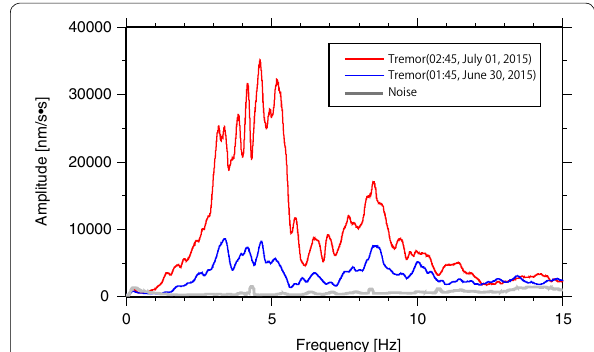
Fig. 5 Examples of amplitude spectra for the vertical ground velocity waveforms at OWD station during the volcanic tremor (blue and red) and the noise record (gray). Each spectrogram was calculated using a waveform of 650 s that was smoothed using a Parzen window with a passband of 0.2 Hz